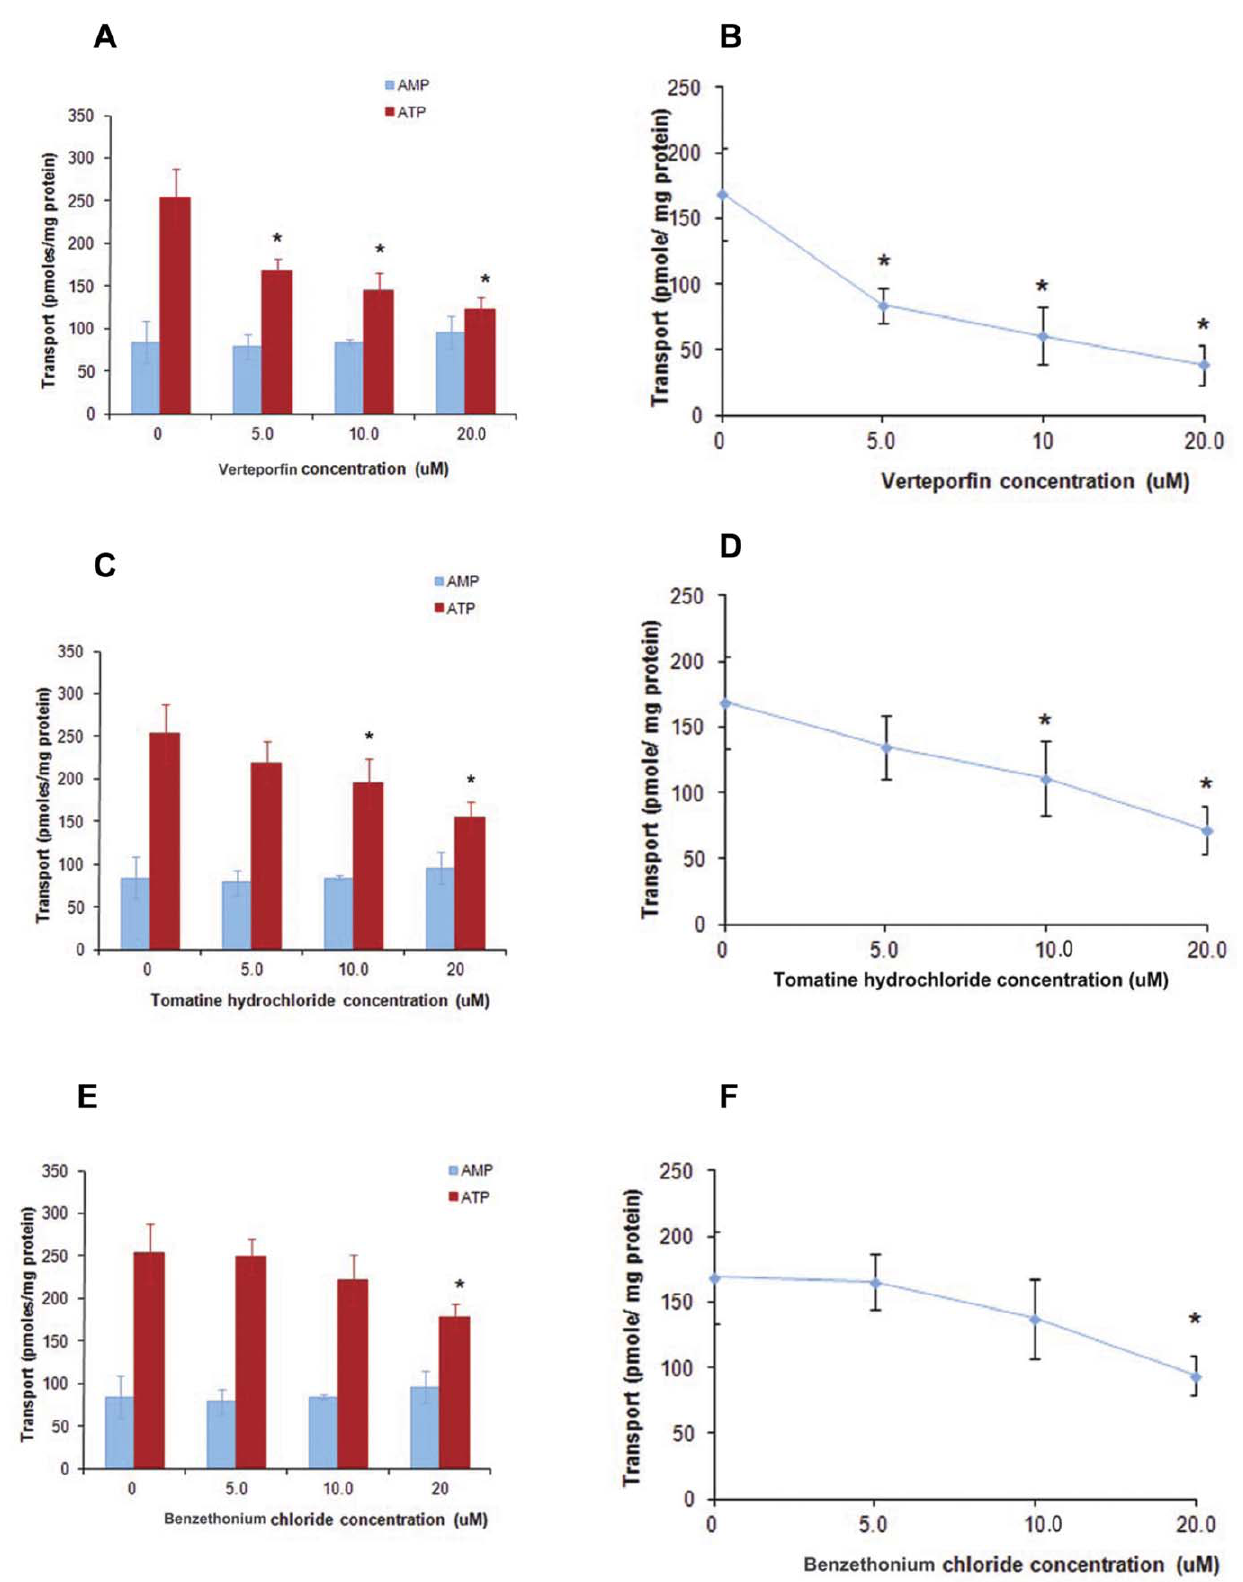
Figure 7. Three of the four compounds identified in the primary HTS screen compete for ABCB6 mediated hemin transport. (a) verteporfin (c) tomatine hydrochloride and (e) benzethonium chloride compete for the transport of 14 C-labeled hemin in the presence of ATP but not in the presence of AMP in mitochondria isolated from ABCB6-overexpressing cells. (b, d, and f) Line graph showing dose dependent competition of